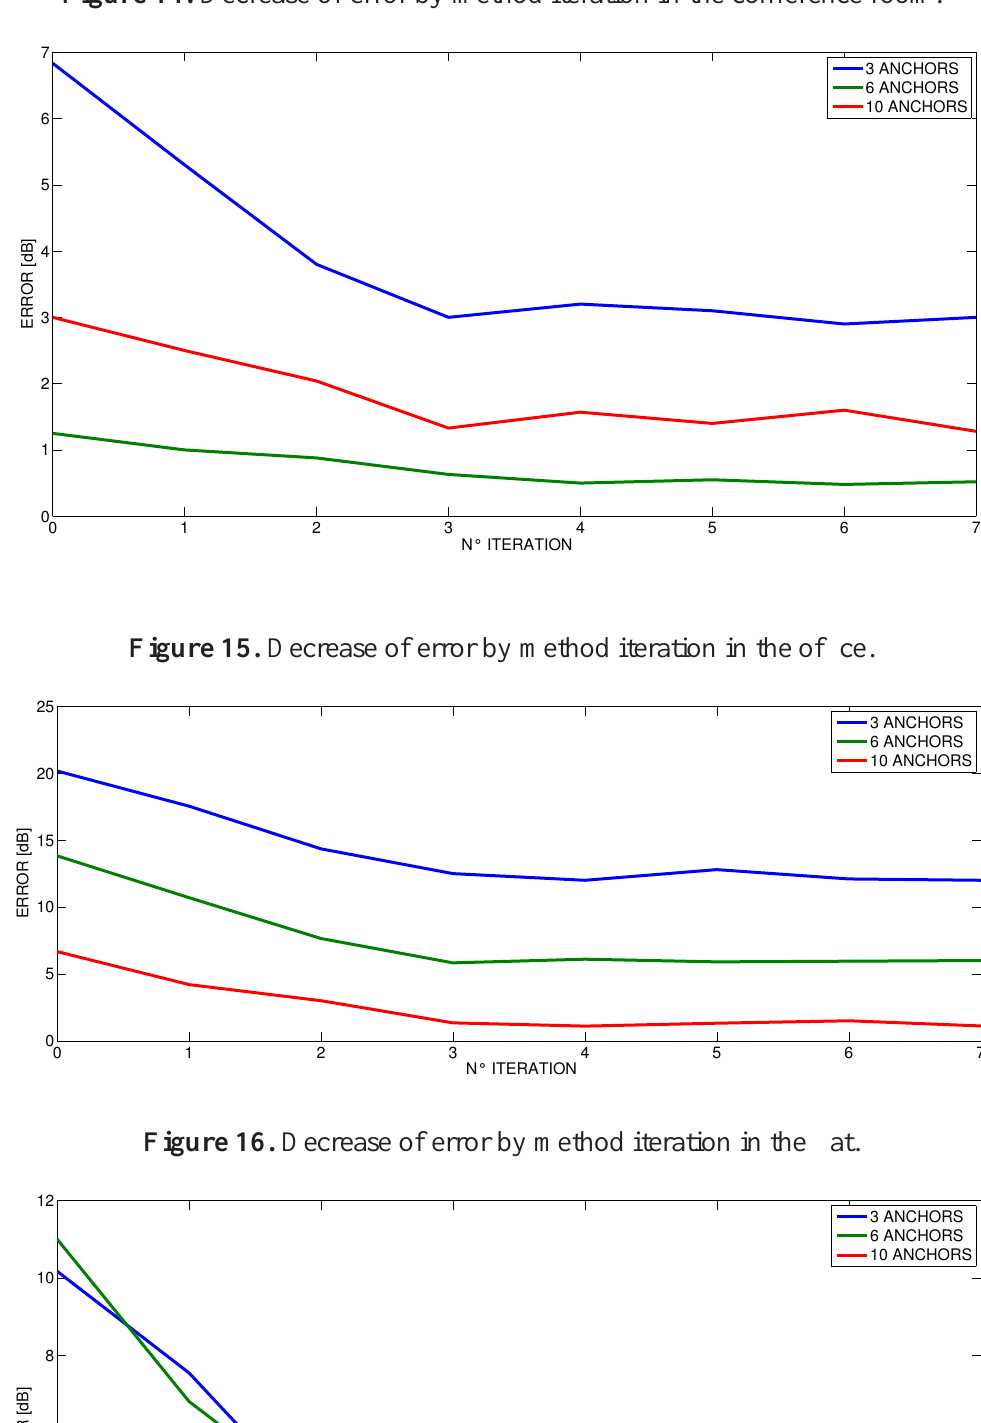
Figure 14. Decrease of error by method iteration in the conference room.